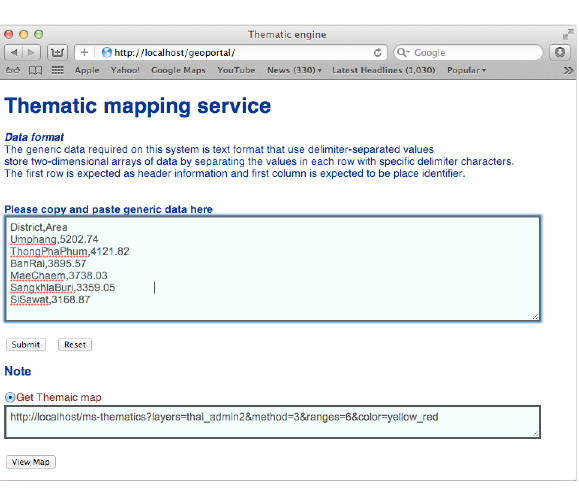
Figure 1. A prototype of thematic map service